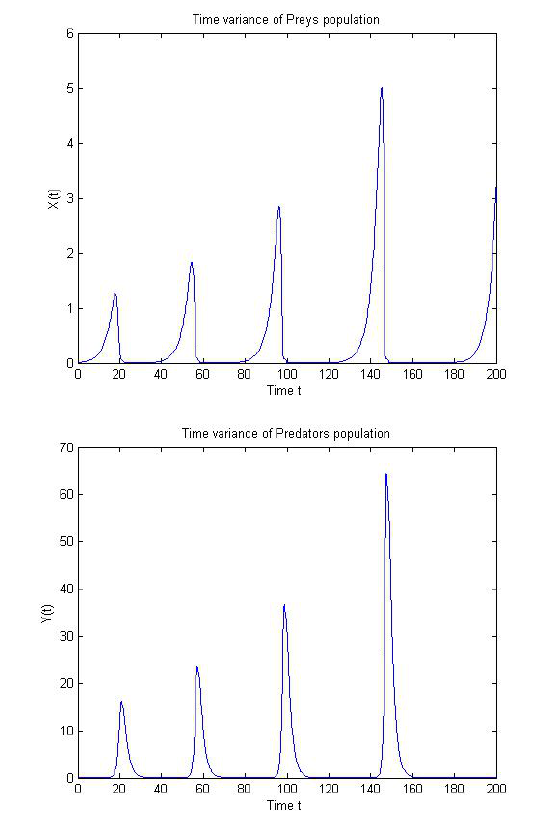
Fig. 9. The positive equilibrium is unstable for τ 1 = 2 and τ 2 = 0 . 5